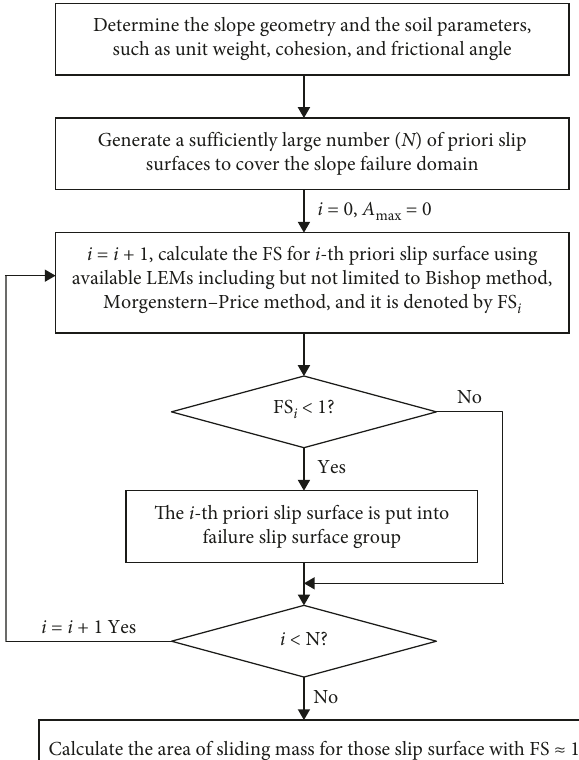
Figure 3: Flowchart of determining failure consequence for a slope failure.